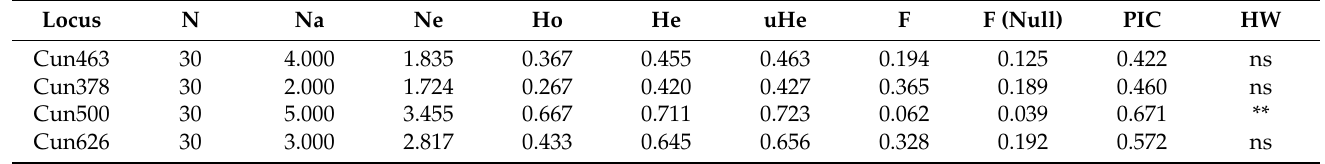
Figure 2. The capillary electrophoresis diagram of the five primer pairs in group G2. (The 8 to 12 in this Figure correspond to alleles loci Cun752, Cun230, Cun27, Cun485 and Cun484, respectively). Table 3. Genetic parameters of 12 microsatellite loci in C.undulatus